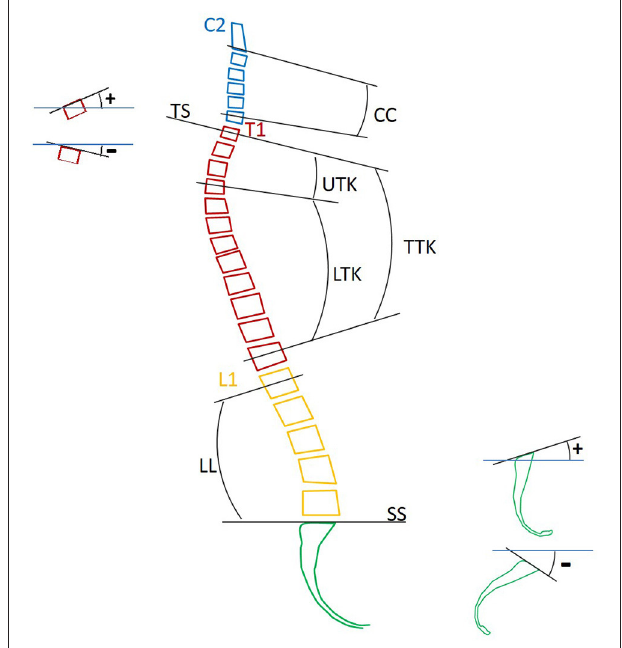
FIGURE 2 | Definitions of the angular measurements for the spinal